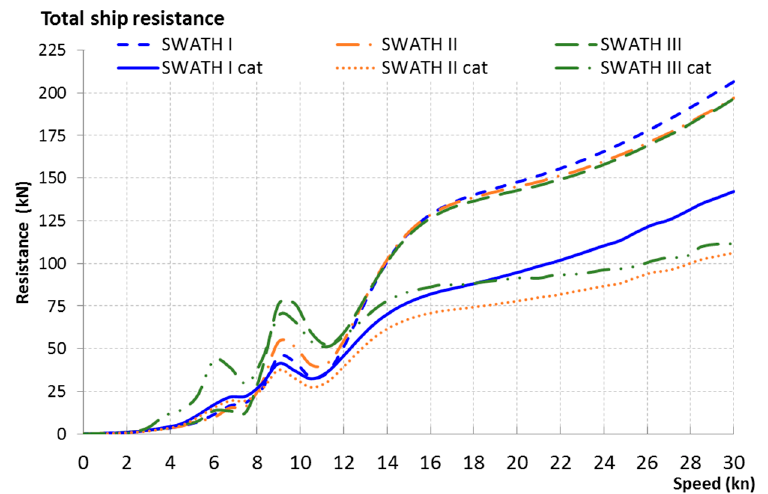
Figure 8. Approximate plot of the relationship of total resistance versus longitudinal speed for SWATH I, SWATH II and SWATH III ships depending on float submerged/surfaced mode.